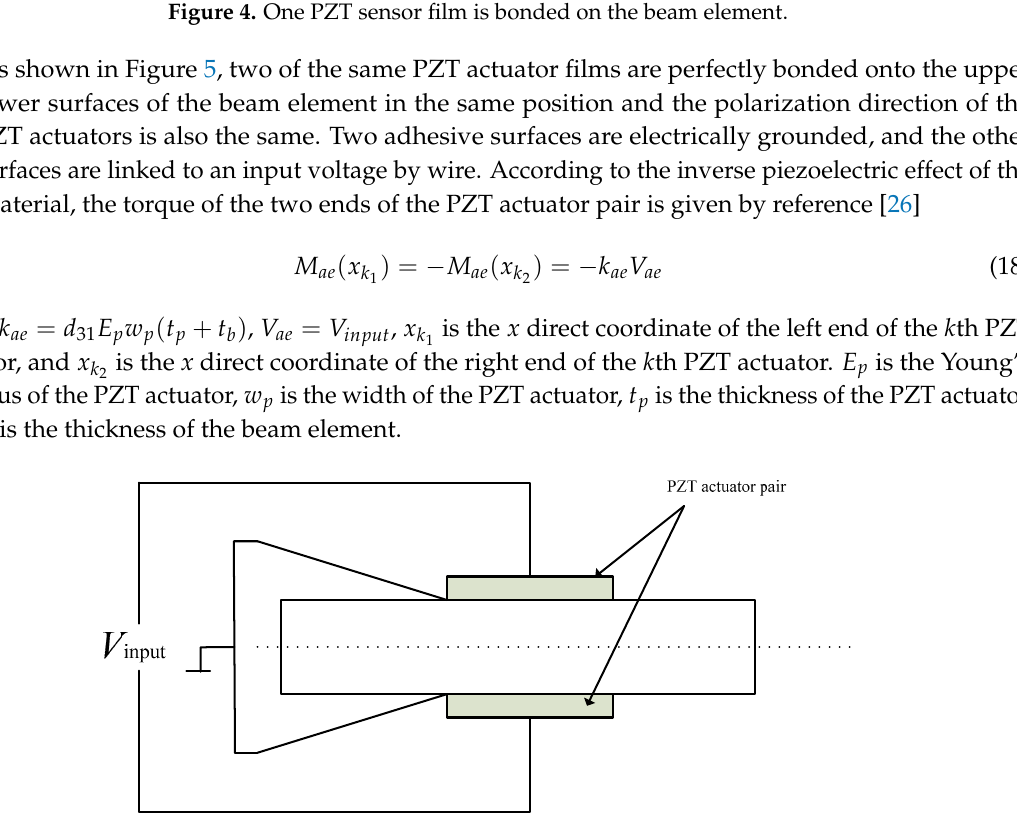
Figure 5. One PZT actuator pair is bonded on the beam element.